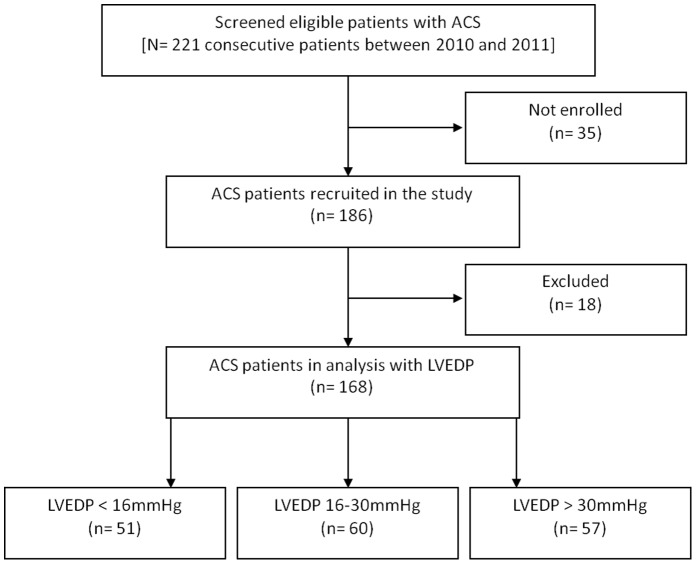
The flow chart of patient selection process.